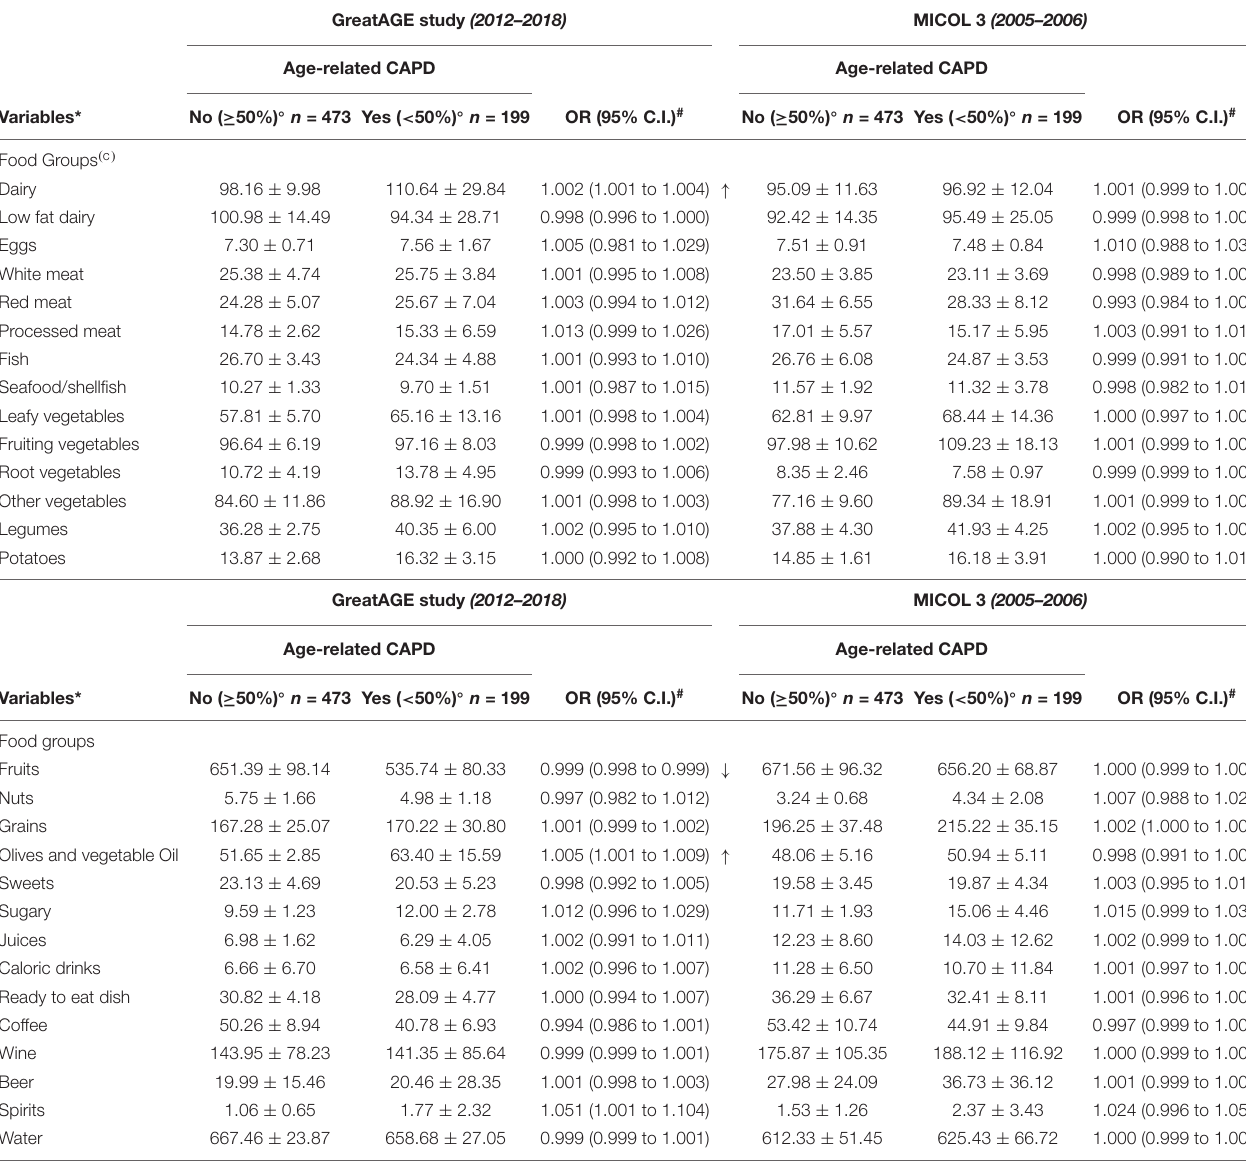
TABLE 2 | Dietary characteristics of the population of the GreatAGE Study examination and about 12 years back in time of the MICOL3 examination (M3) ( n = 734, non-age-related CAPD n = 473, age-related CAPD n = 199, missing n =